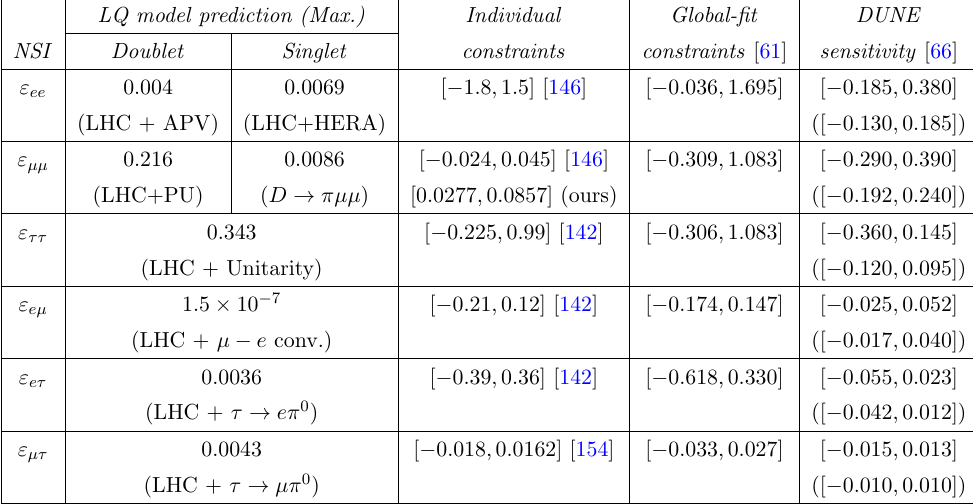
Table 17 . Maximum allowed NSI (with d -quarks) in the one-loop LQ model, after imposing the constraints from APV (section 5.1.1), cLFV (sections 5.1.2, 5.1.5, 5.1.6), LEP and HERA contact